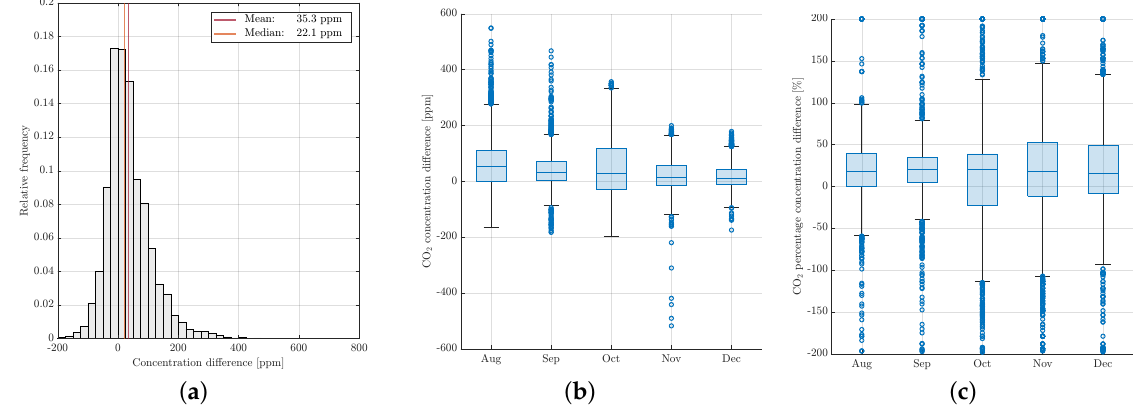
Figure 9. CO 2 concentration difference between the front and the back of the classroom. ( a ) shows the distribution of the differences. ( b ) shows monthly differences. ( c ) shows monthly results as a percentage of the difference between mean concentration and external concentration, which is assumed to be 380